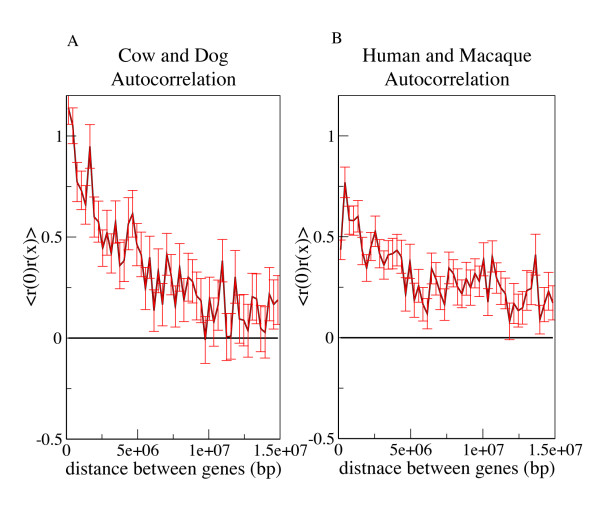
Autocorrelation of normalized substitution rates r for cow-dog (a) and human-macaque (b). In each species pair, nearby genes have correlated silent site substitution rates even at distances up to 10 Mb. These lengthy regional biases are typical of mammalian genomes, and are much larger than those of the Candida fungi.